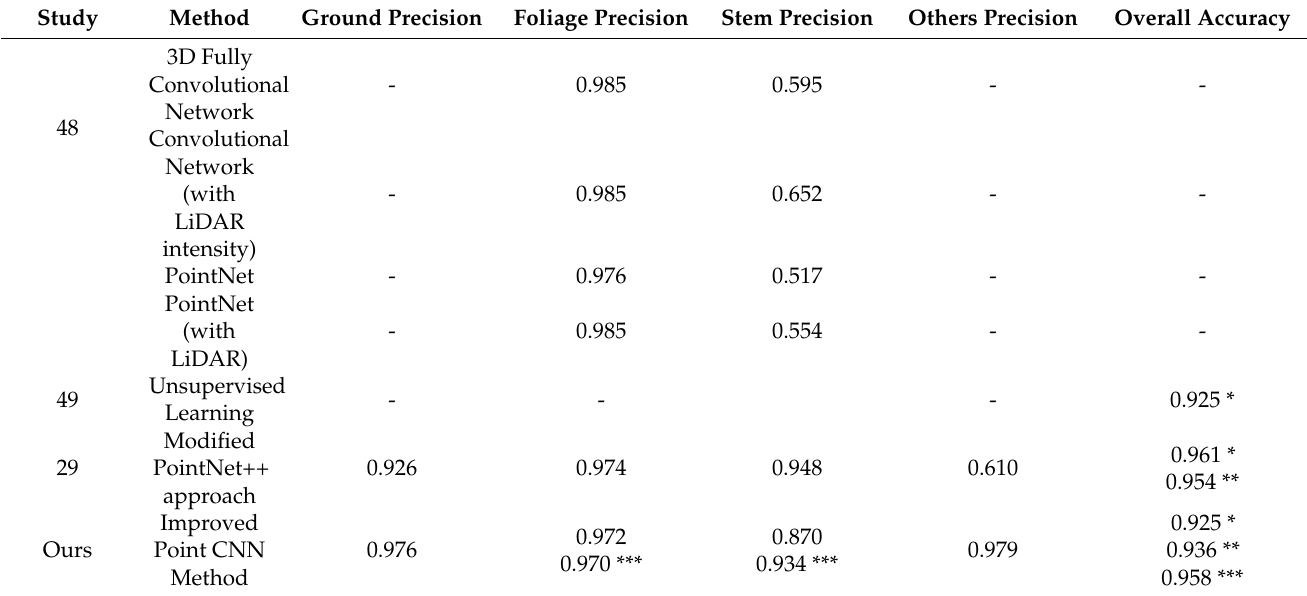
Table 3. Comparison of segmentation results against similar studies. Bold numbers denote the top score in each metric.